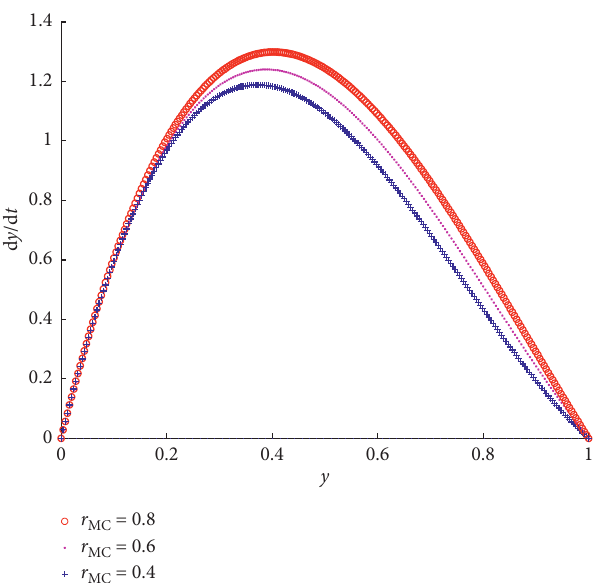
Figure 8: Analysis of simulation test results 2.